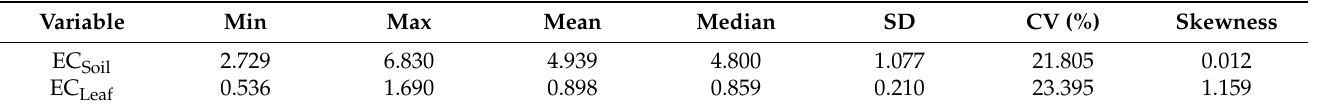
Table 5. Descriptive statistics of the soil and leaf samples’ electrical conductivity (EC, mS/cm) dataset.